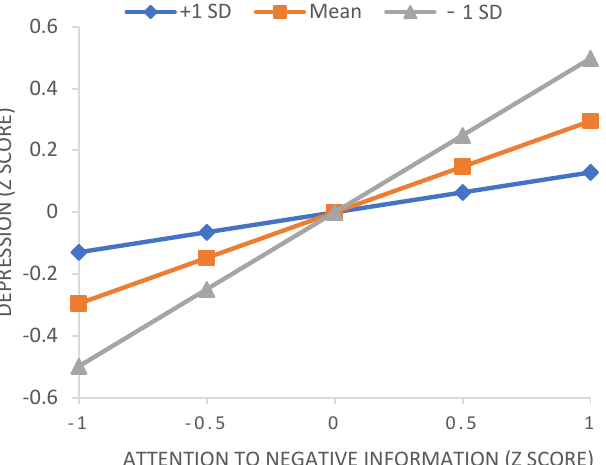
Figure 3. Depression predicted by attention to negative information moderated by socio-emotional skills. +1 SD, one standard deviation above the mean; −1 SD, one standard deviation below the mean.